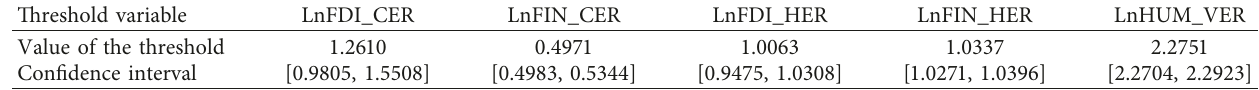
Table 5: Threshold values and 95% confidence intervals of threshold variables.